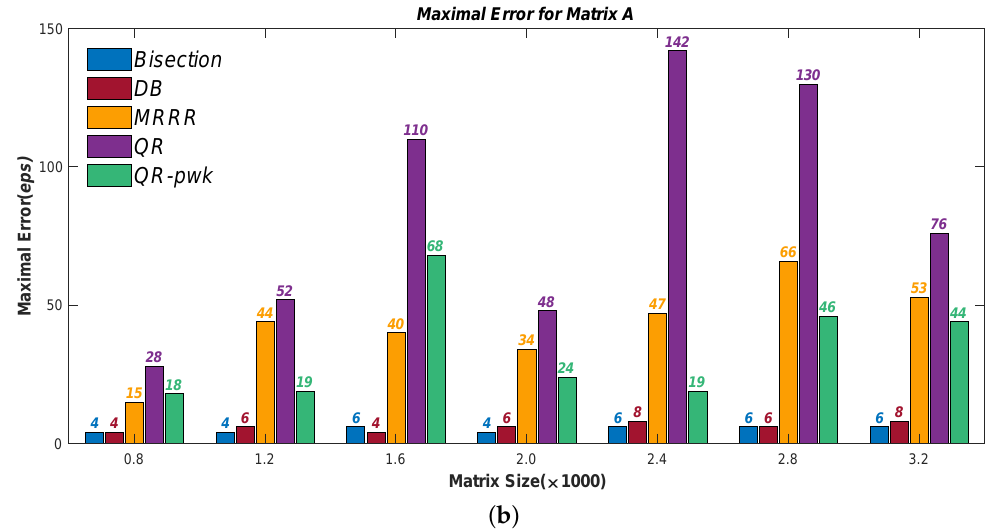
Figure 1. Results of Matrix A: ( a ) the Average Errors; ( b ) the Maximal Errors. Average Error for Matrix T1